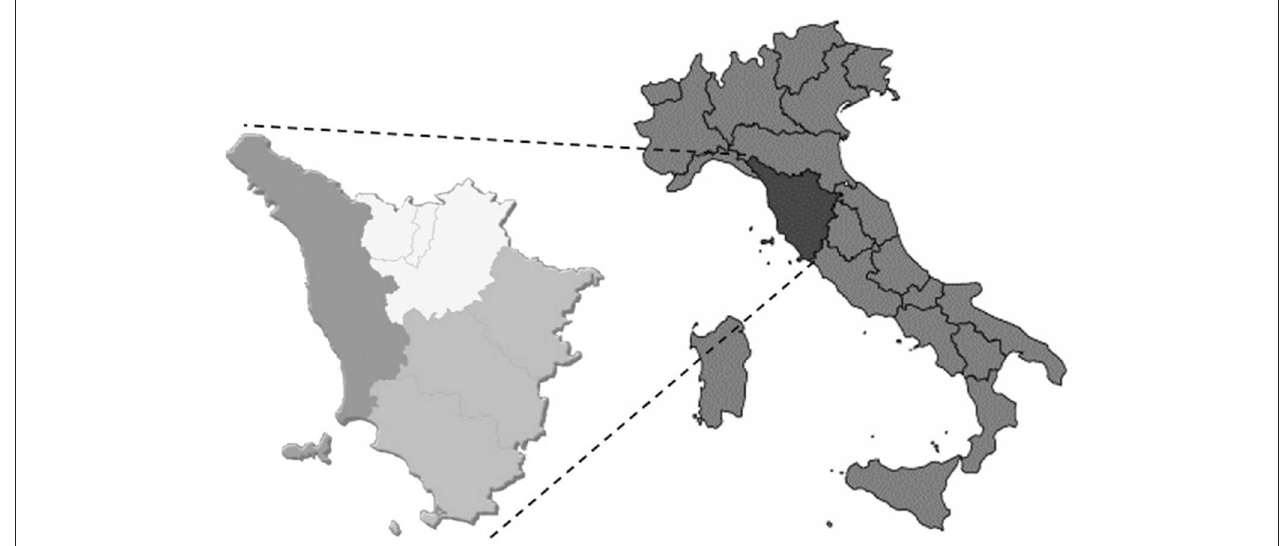
FIGURE 1 | Tuscany’s local health authorities. Central Tuscany LHA; South-East Tuscany LHA; North-West Tuscany LHA.